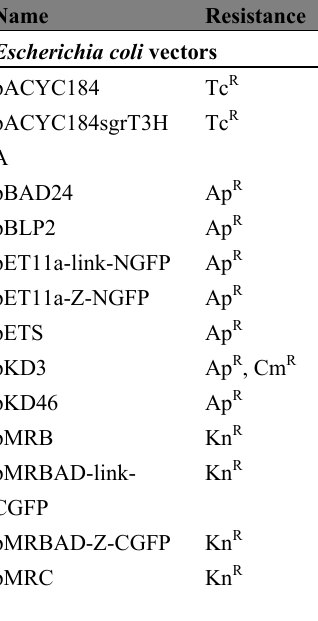
Table 2. Plasmids used in this